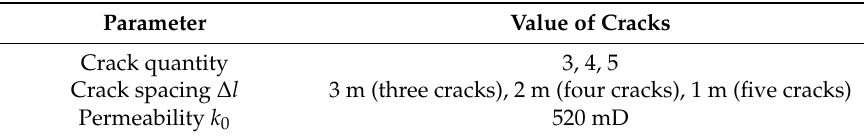
Table 3. Parameters of